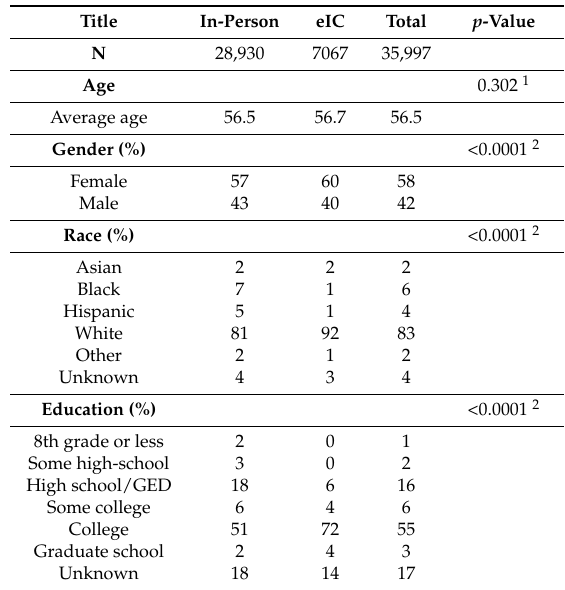
Table 2. Comparison of in-person and eIC demographics (Jun 2014 to Jan